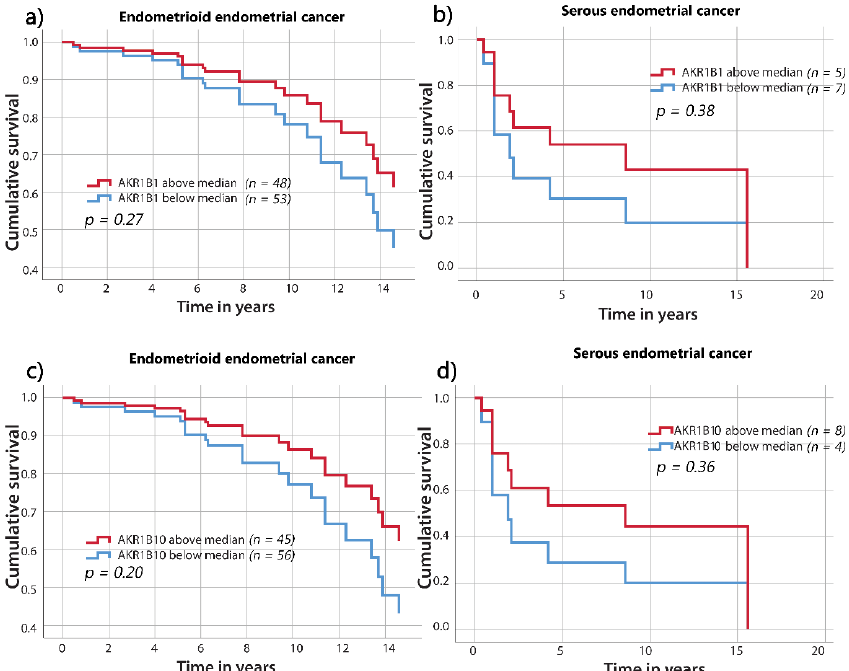
Figure 6. Overall survival curves for AKR1B1 and AKR1B10 in patients with endometrioid and serous EC. AKR1B1 in patients with ( a ) endometrioid EC ( p = 0.27) and ( b ) serous EC ( p = 0.38). AKR1B10 in patients with ( c ) endometrioid EC ( p = 0.20) and ( d ) serous EC ( p = 0.36). The groups are separated according to their median values. Time on x -axis represents time elapsed since initial diagnosis. AKR1B1: aldo-keto reductase family 1 member B1; AKR1B10: aldo-keto reductase family 1 member B10.